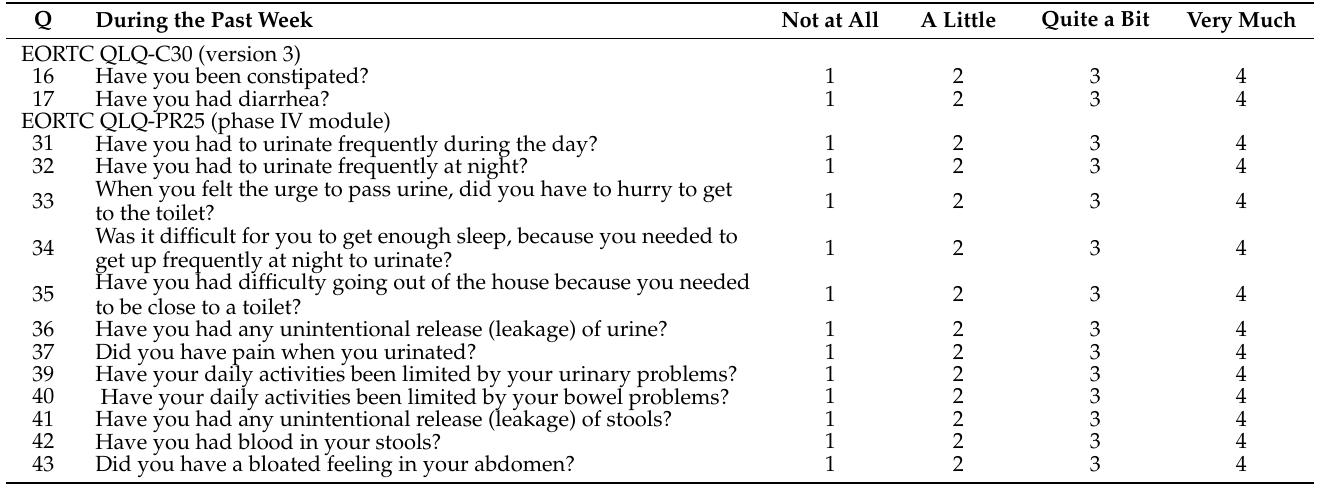
Table 1. Subset of 14 questions of the EORTC QLQ-C30 and PR25 regarding genitourinary and gastrointestinal toxicity, including 10 questions enabling a direct comparison with physician-reported